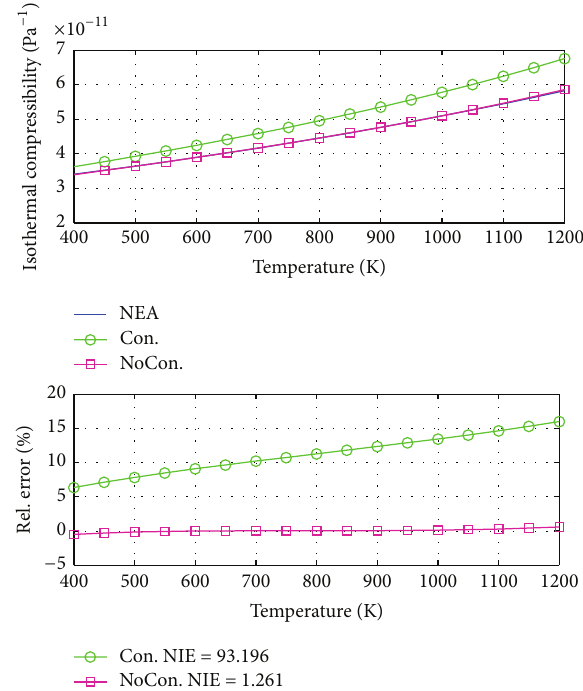
Figure 15: LBE isothermal compressibility, NEA data versus con- strained and nonconstrained optimization